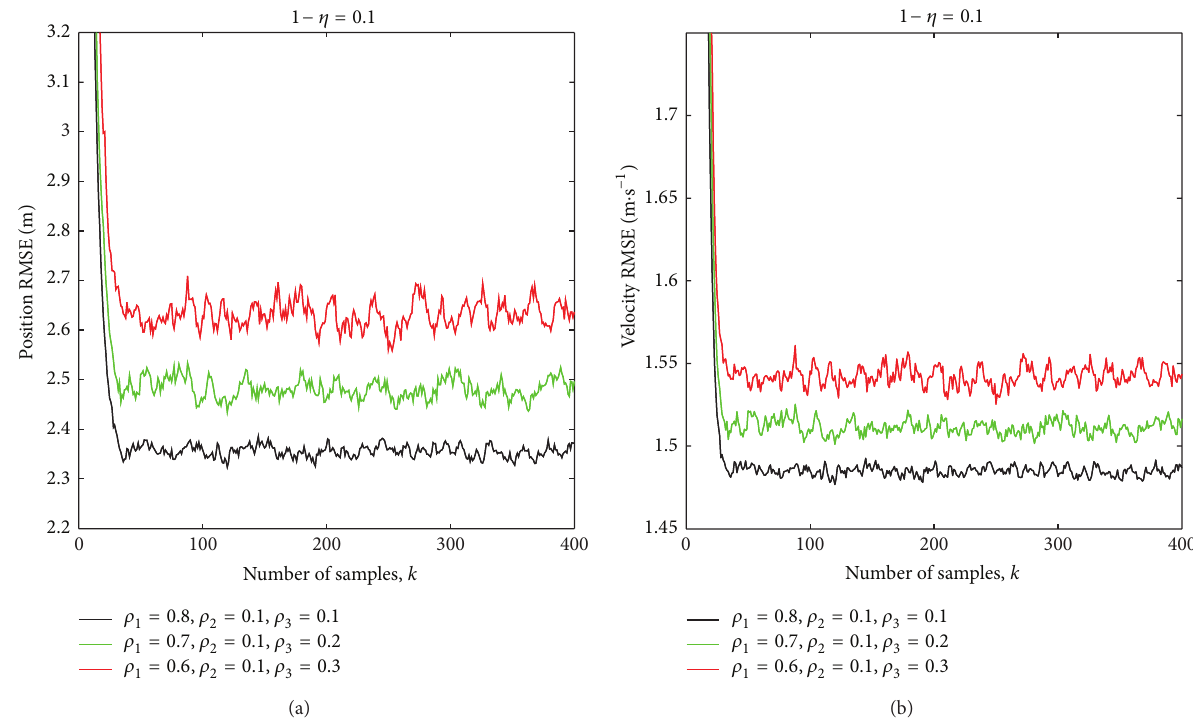
Figure 1: Comparison of the RMSEs for the proposed algorithm with different 𝜌 𝑞 (𝑞 = 1, 2,3) : (a) position RMSE; (b) velocity RMSE.